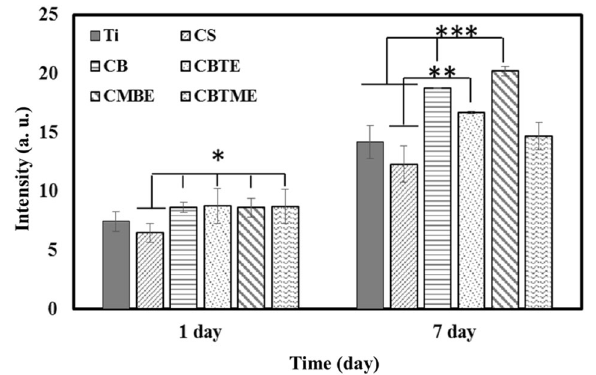
Fig. 4 Alamar blue assay of experimental groups after 1 and 7 days (* P < 0.05, ** P < 0.01, *** P <